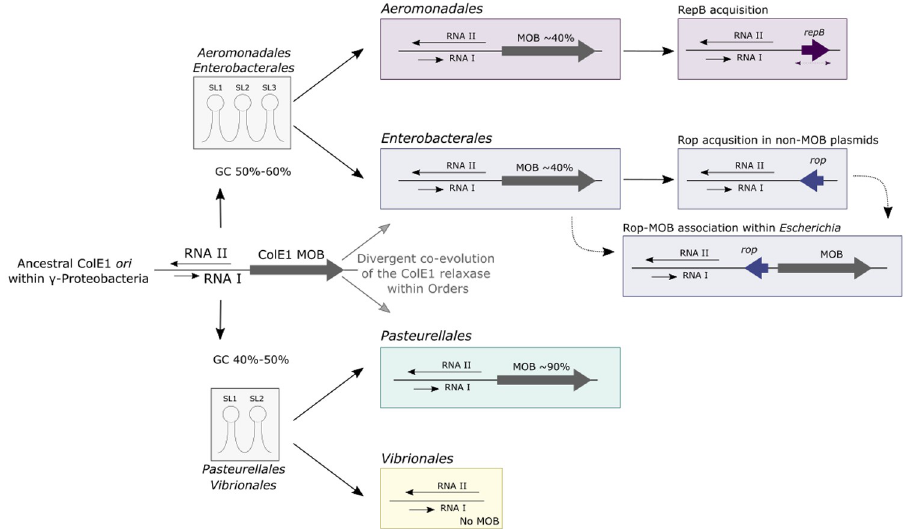
Fig 7. Evolutionary history of the ColE1 plasmids. The schematic representation of the ColE1 ori is illustrated with two antisense black arrows for both the RNAI and RNAII, and the ColE1 relaxase with a thick grey arrow annotated as MOB. The divergent evolution of the ColE1 ori within Aeromonadales / Enterobacterales and Pasteurellales / Vibrionales , respectively, is represented with black arrows ending in two grey boxes, each of them showing three (SL1-3) or two stem loops (SL1-2). At the right of the figure, the genetic elements related to the ColE1 plasmids within each Order are represented. The rop gene in Enterobacterales is represented with a blue arrow; the repB gene in Aeromonadales with a purple arrow; and the dashed purple arrow below the repB gene represents its variable location within the plasmid.